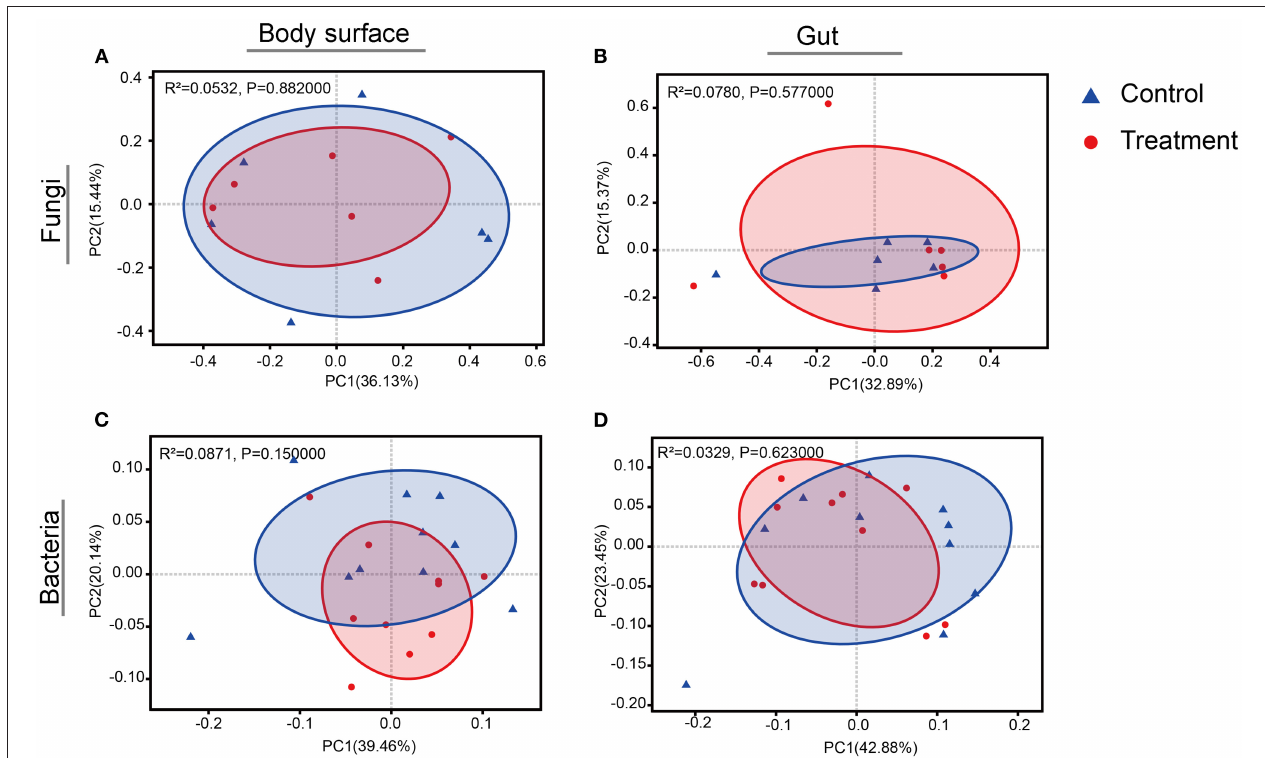
FIGURE 2 | Principal coordinate analysis (PCoA) plots of body surface samples and gut samples for microbial community analysis. (A–D) PCoA plots of fungal body surface samples, fungal gut samples, bacterial body surface samples, and bacterial gut samples, respectively. PCoA plots are based on the weighted UniFrac metric for microbial communities. Blue triangles represent body surface or gut samples treated by sterilized PBS (control), and red dots represent samples treated by B. bassiana conidial suspension. Significance values refer to analysis of similarity (Adonis, p < 0.05) test for differences in community composition between the control and the B. bassiana -treated